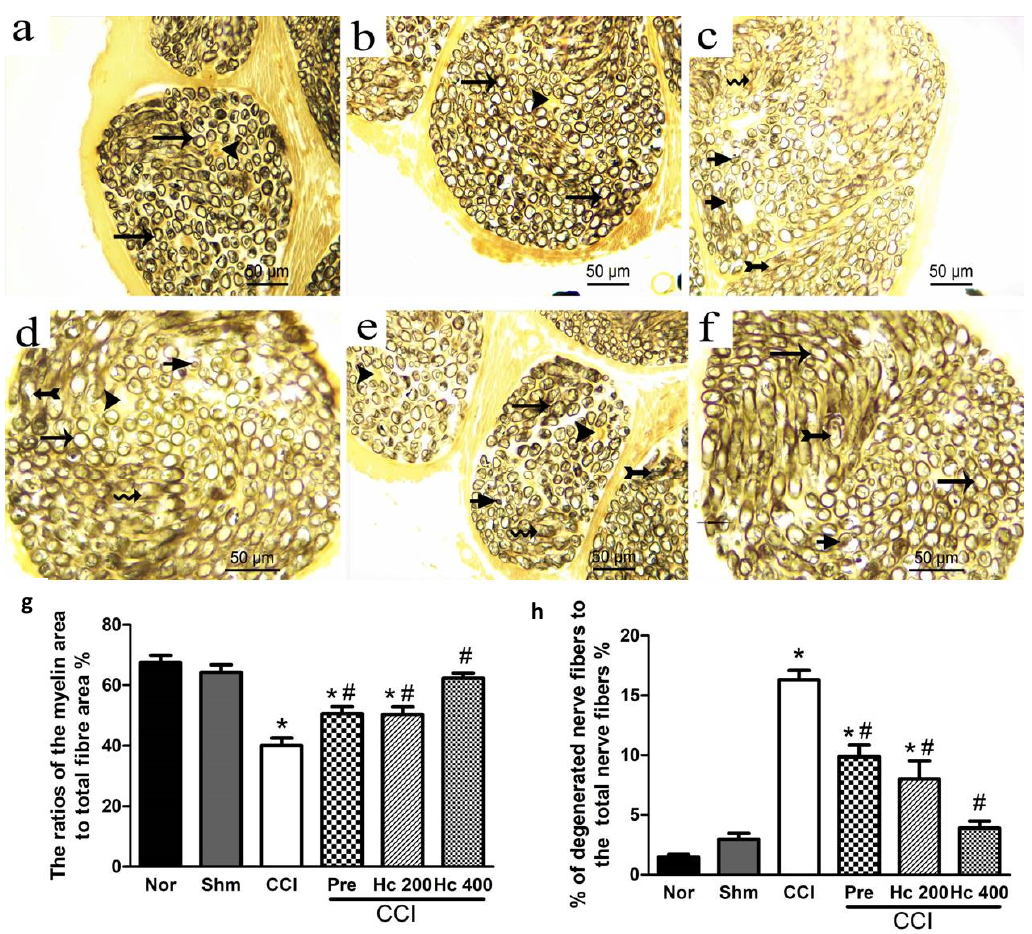
Figure 15. Photomicrographs of sciatic nerve transverse sections stained with osmic acid in: ( a ) normal group; ( b ) sham group; ( c ) CCI group; ( d ) pregabalin group; ( e ) H. campechianum flower extract (p.o., 200 mg/kg); ( f ) H. campechianum flower extract (p.o., 400 mg/kg). Arrow, arrowhead, bifid arrow, short arrow and wavy arrow illustrate the normal myelin sheath concentric lamellar structure, unmyelinated nerve fibres, compromised normal myelin sheath concentric lamellar structure, invagination of the myelin sheath into the axon and axonal swelling, respectively. Lower panel represents the ratio of myelin sheath to the total nerve area ( g ) and the percentage of degenerated nerve fibres to the total nerve fibres number ( h ). Data are presented as mean values ± S.E.M. (n = 5–7). * p < 0.05, compared to the sham group; # p < 0.05, compared to the CCI group. Scale bar, 50 µ m × 400. CCI, chronic constriction injury; Hc, H. campechianum ; Nor, normal; Pre, pregabalin; Shm, sham.